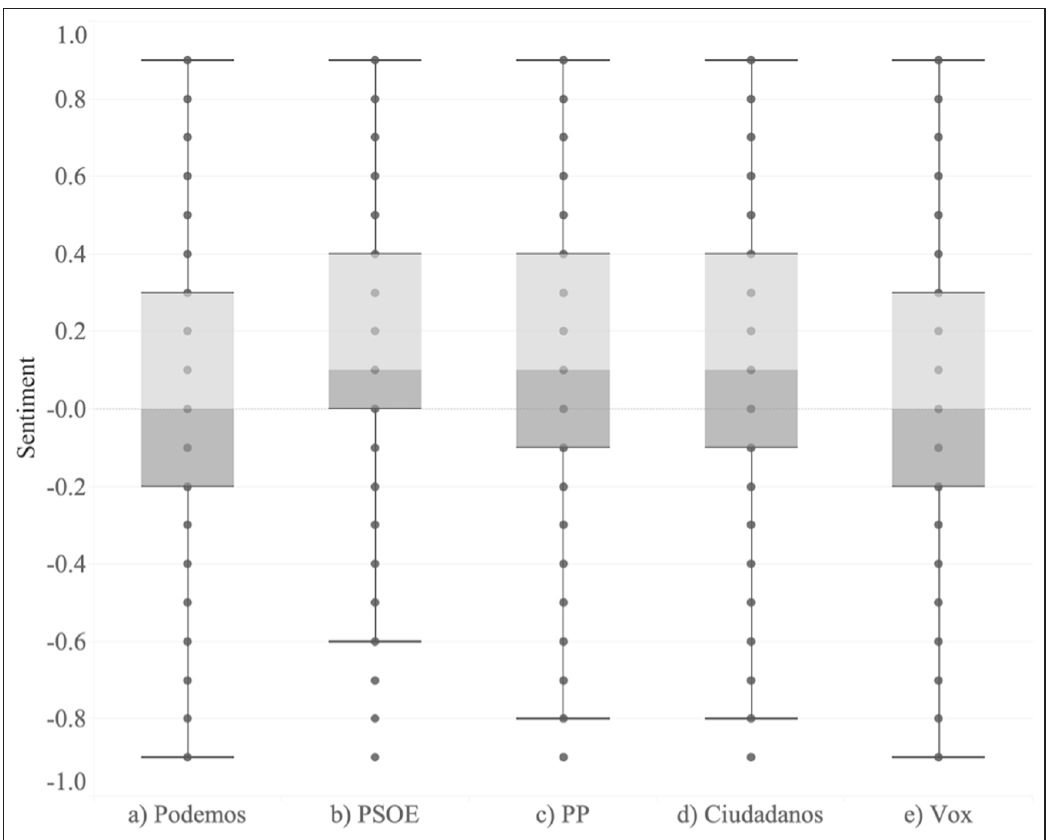
Figure 5: Overall Sentiment by Party (all